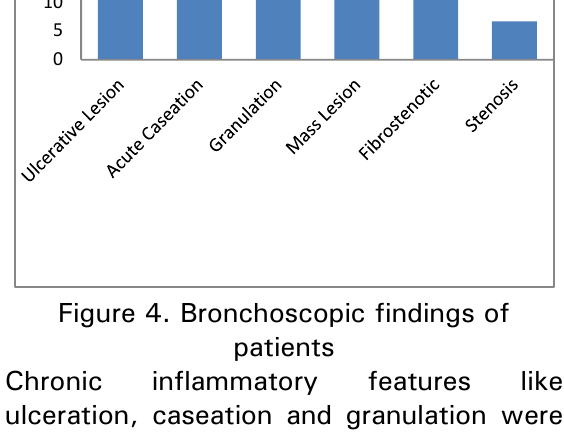
Figure 4. Bronchoscopic findings of patients Chronic inflammatory features like ulceration, caseation and granulation were common.